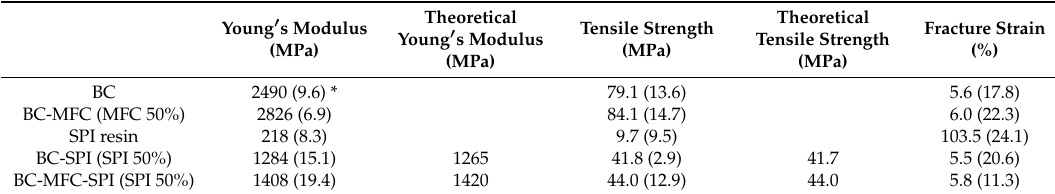
BC-MFC-SPI (SPI 50%) 1408 (19.4)